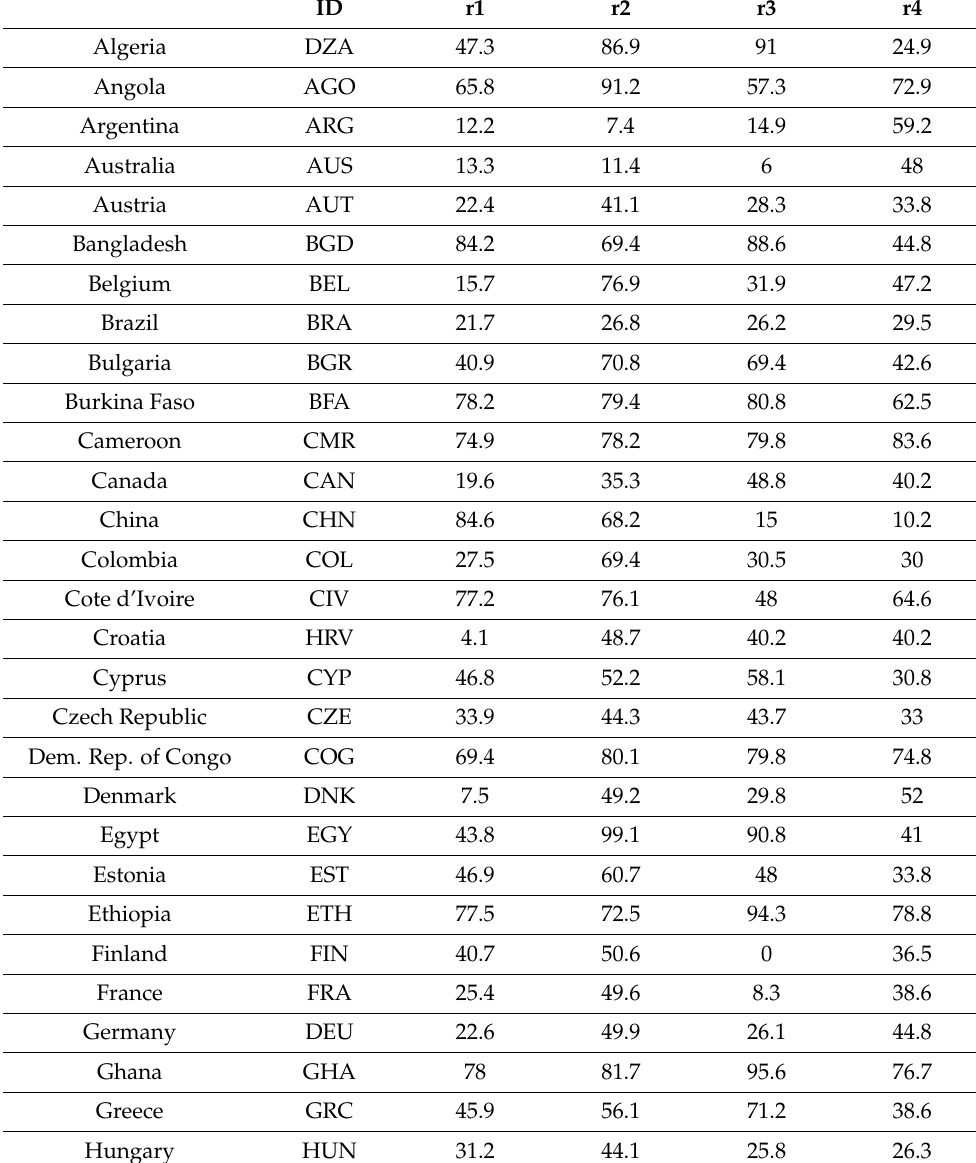
Table 11. Data matrix of the food sustainability. A total of 78 countries are characterized by the numerical values of four